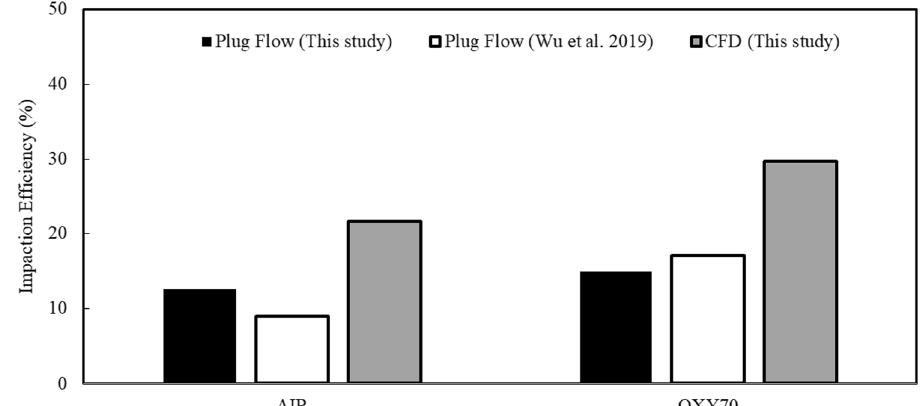
Fig. 4 Impaction efficiency predictions using plug flow and CFD